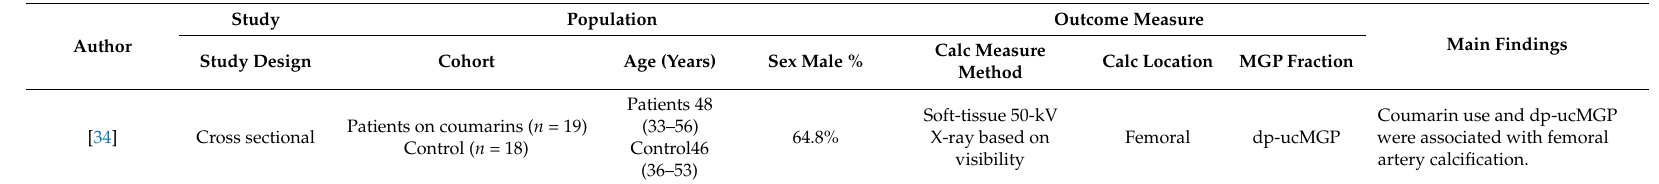
Table 4. Association between MGP fractions and vascular calcification in patients taking vitamin K antagonists.